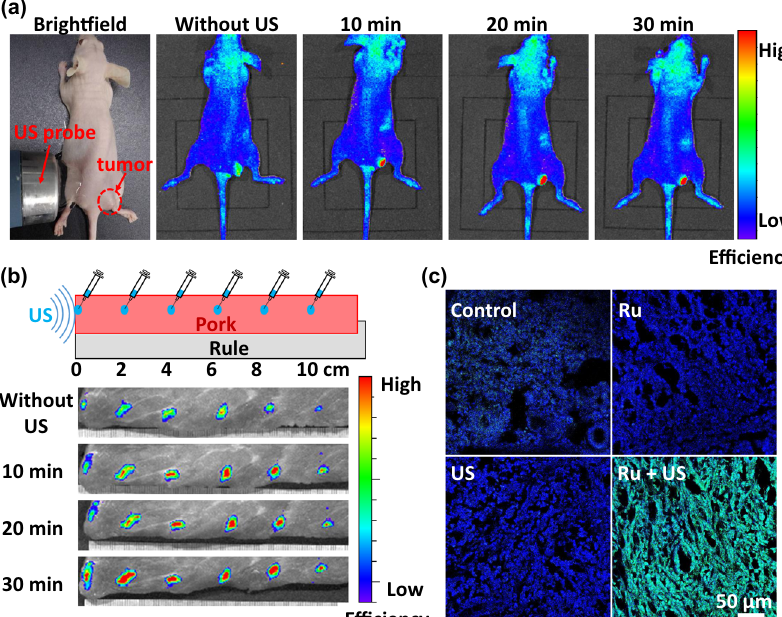
Fig. 4 ROS generation in deep tissue. a The fl uorescence imaging of 4T1 tumor-bearing nude mice with i.t. injection of SOSG and [Ru(bpy) 3 ] 2 + for varied US irradiation durations. The tumor tissue position is pointed out by red circle. b The fl uorescence imaging to investigate 1 O 2 generation in the presence of [Ru(bpy) 3 ] 2 + and SOSG in deep pork tissue (>10cm) under 30 min US irradiation. SOSG and [Ru(bpy) 3 ] 2 + mixing solution was injected at different distances (every 2 cm position) from the US probe into pork. c The fl uorescence imaging of DAPI (blue) and DCFH-DA (green) co-stained tumor slices collected from mice after different treatments. Ru: [Ru(bpy) 3 ] 2 + ; US: 0.3 W cm − 2 , 3